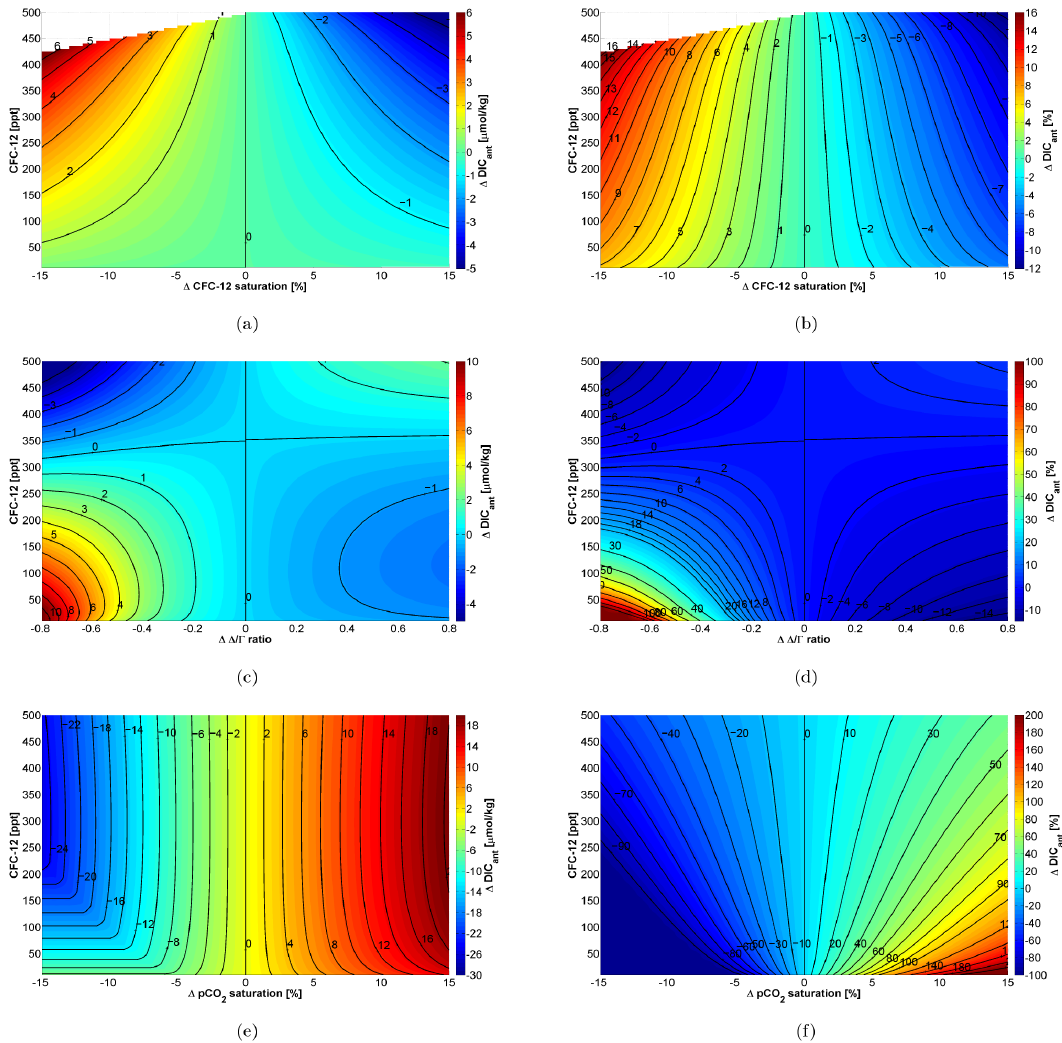
Figure 12. Anthropogenic carbon concentration sensitivities as a function of CFC-12 concentrations vs. changes in (a, b) CFC-12 saturation, (c, d) (cid:49)/(cid:48) ratio and (e, f) p CO 2 saturation. Deviations are stated in absolute (left panels) and relative (right panels) values. The reference points are defined by 100% saturation of CFC-12 and p CO 2 and a ratio of (cid:49)/(cid:48) = 1 .